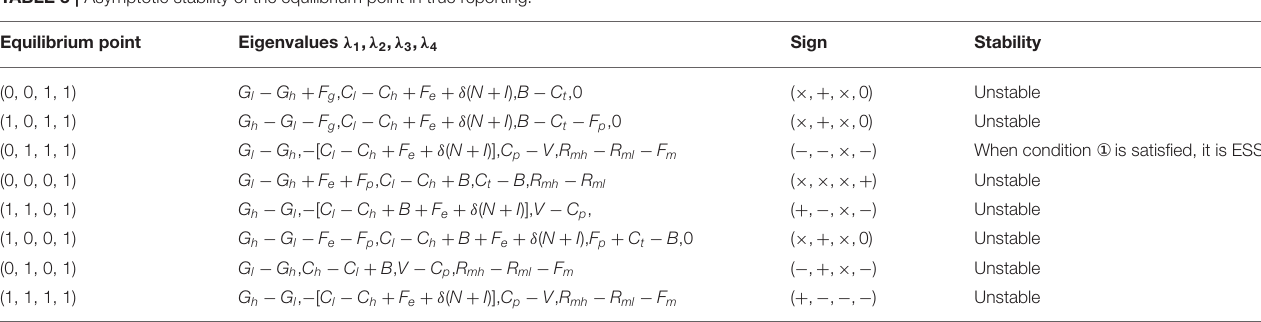
TABLE 3 | Asymptotic stability of the equilibrium point in true reporting.